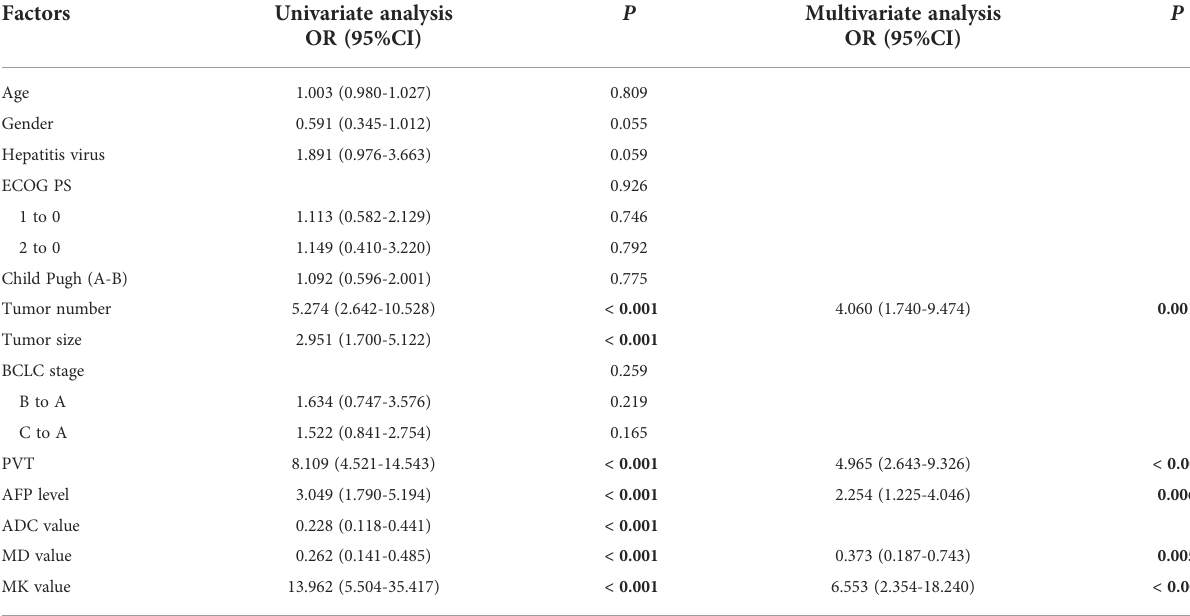
TABLE 4 Uni- and multi-variate analysis of prognostic factors associated with overall survival of 97 patients with large hepatocellular carcinoma who underwent liver